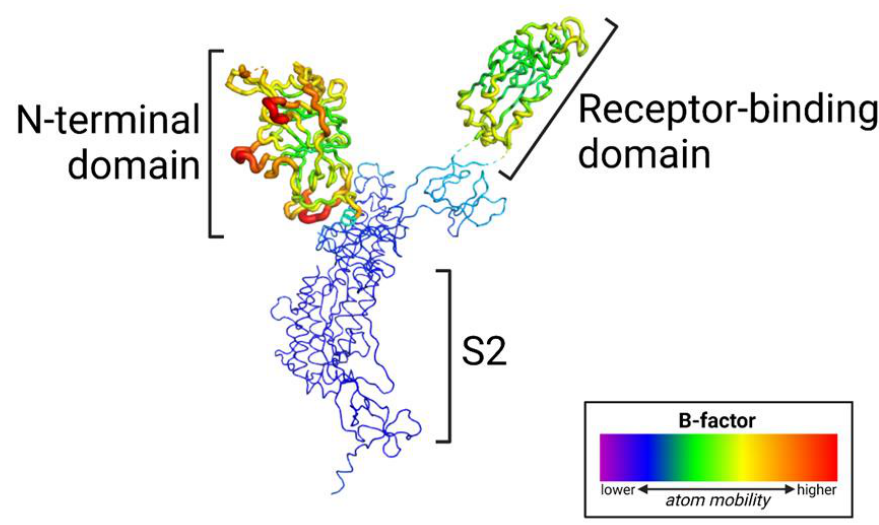
Figure 2. The N-terminal domain (NTD) of the SARS-CoV-2 spike glycoprotein exhibits a high level of flexibility. The cryo-EM structure of the prefusion spike protein is colored by B-factor; the thickness of the wire corresponds to structural variability.